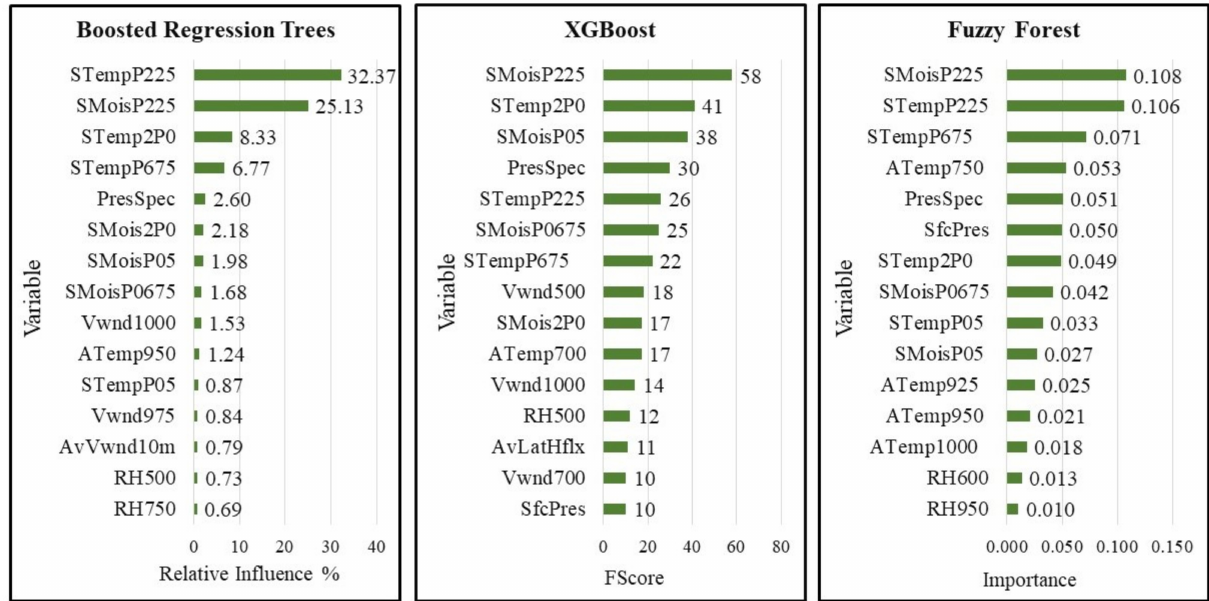
Figure 8. Variable ranking based on different implemented variable selection models. The ranking is performed based on relative influence percentage in BRT, feature score in XGBoost, and feature importance score in Fuzzy Forest. The RF(VSURF) model only provided rankings of the variables without their corresponding relative importance, please refer to Table 5 for the ranking.